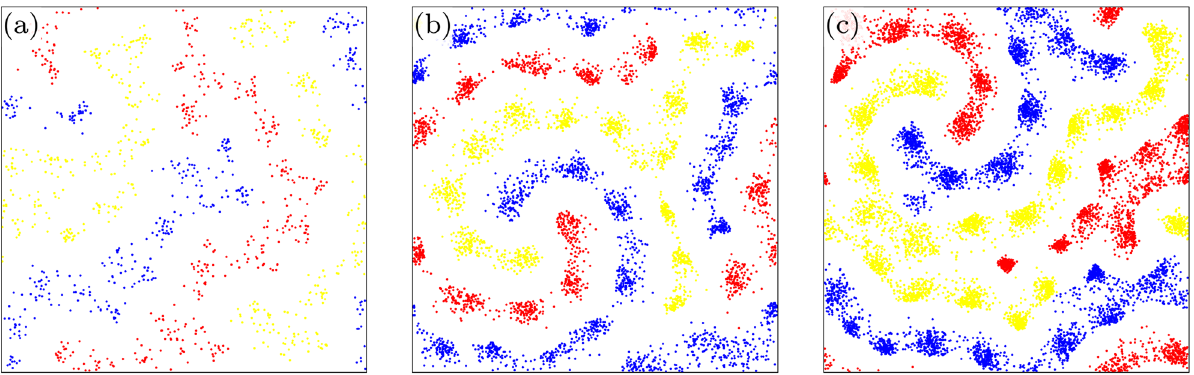
Figure 5. Characteristic spatial distribution of species at ℓ p = ℓ r = 0.1 , ℓ m = 0.01 parameter values. The only difference is we use M = 30 on panel ( a ), M = 120 on panel ( b ) and M = 240 on panel ( c ).